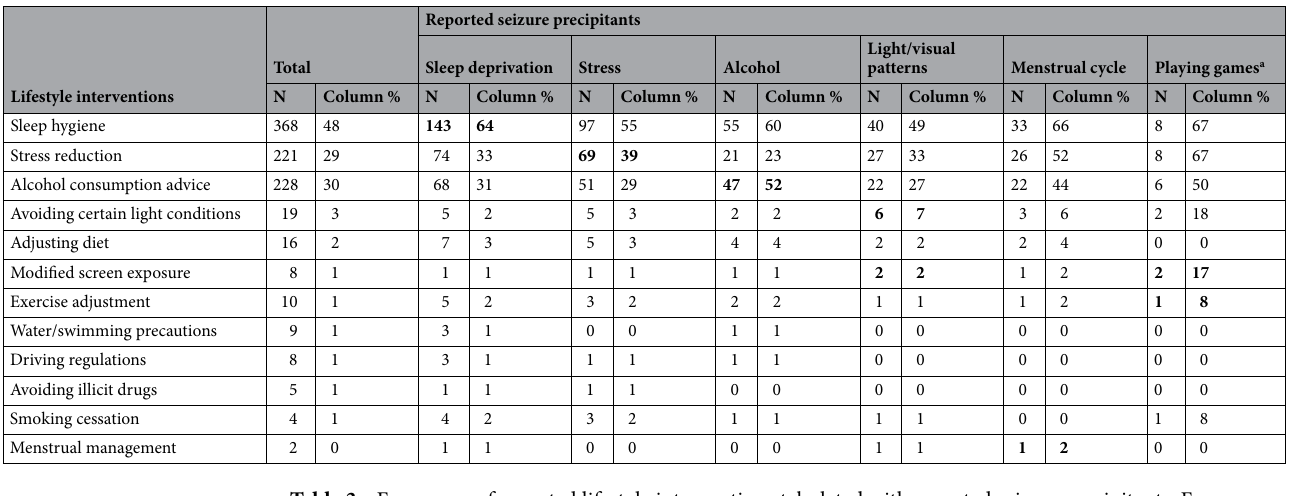
lence of drug resistance between males and females (Table 1, χ 2 (1) = 1.5, p = 0.22). Drug-resistant individu- als were significantly older at the time of recruitment than seizure-free individuals (median age seizure-free 22 years vs drug-resistant 26 years, U = 19,626, p < 0.001). Seizure precipitants. In females, drug resistance was associated with experiencing seizures precipitated by menstrual cycle (OR = 4.9 (95% CI = 2.5–9.7), p < 0.001), stress (OR = 2.4 (95% CI = 1.4–3.9), p < 0.001) and con-